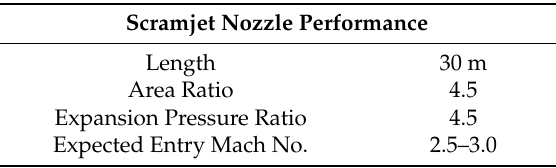
Table 3. Scramjet nozzle performance data.